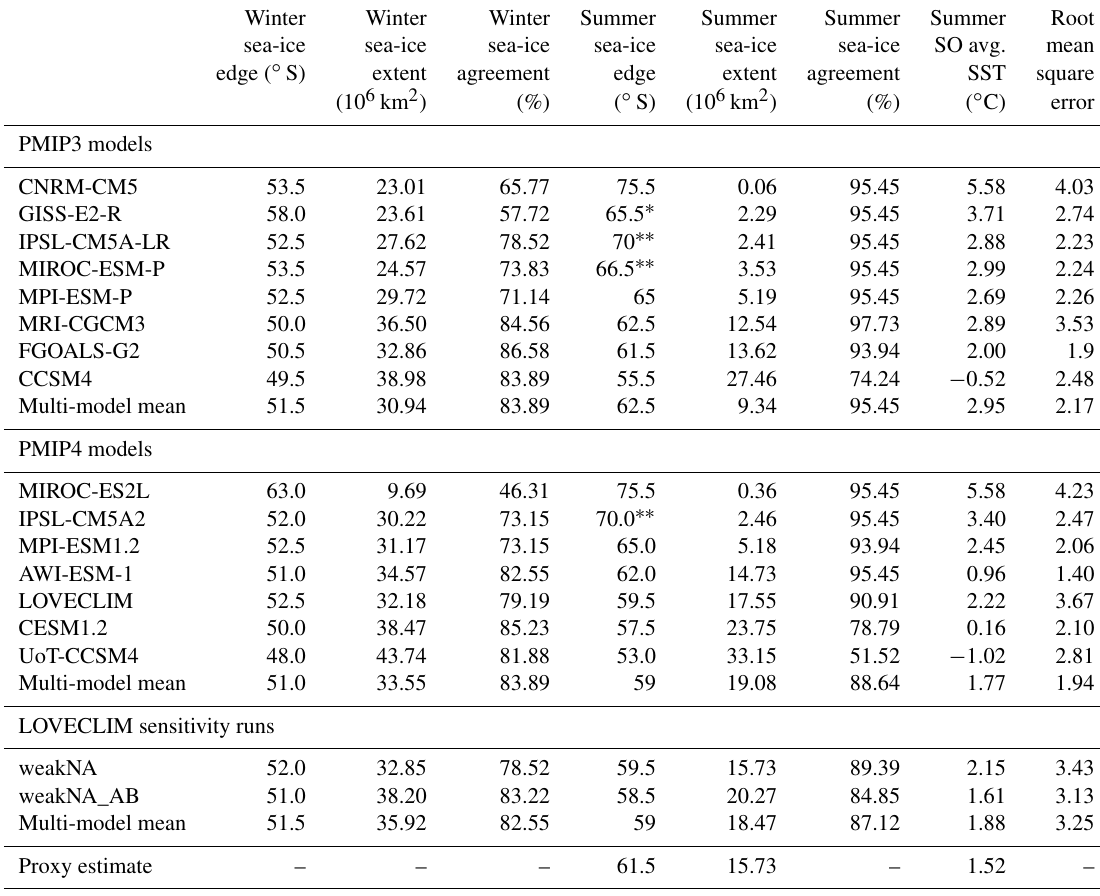
Table 3. Simulated seasonal sea-ice characteristics and austral summer SST, list from lowest to highest annual sea-ice extent. Model data agreement is calculated as the percentage of the correctly simulated sea-ice state at the location of proxies (presence of sea-ice or ice-free conditions, with possible presence of sea-ice considered ice-free). The austral summer SO SST is meridionally averaged over 75 to 50 ◦ S. The austral summer sea-ice edge is taken at the mean 15% concentration. Calculated root-mean-squared error (RMSE) values use the summer SSTs from proxy data in comparison to the modeled summer SST